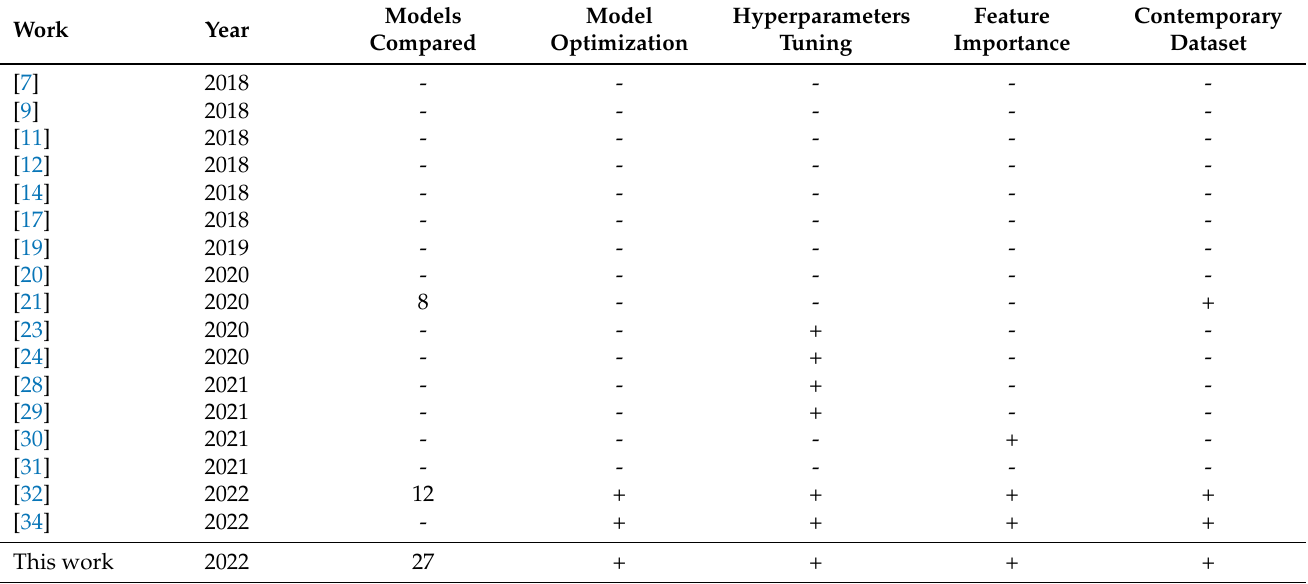
Table 1. Overview of the related work. A plus sign denotes that the respective work addresses the criterion of the corresponding column. The figures in the third column denote the number of ML models examined by each study. A dash in the same column means that the respective work did not make a comparison between two or more different